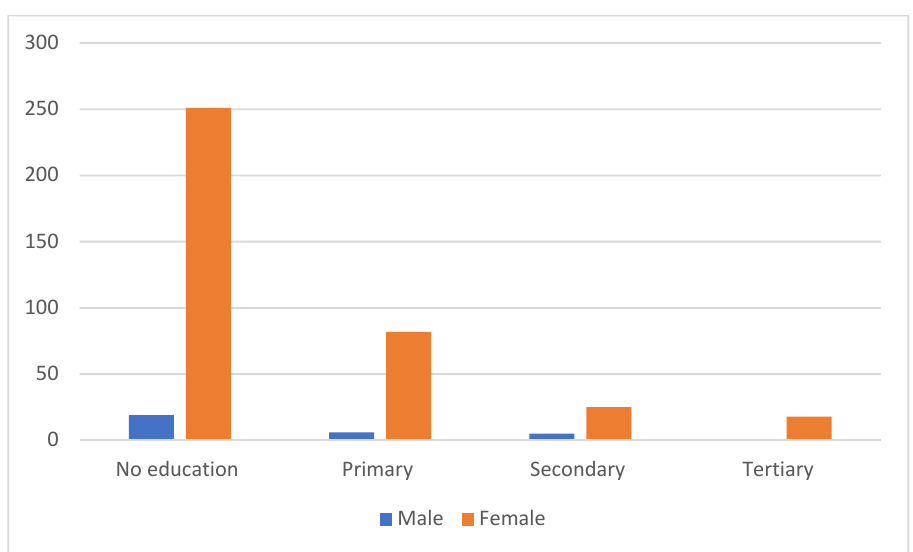
Figure 2. Distribution of respondents’ education level by age.